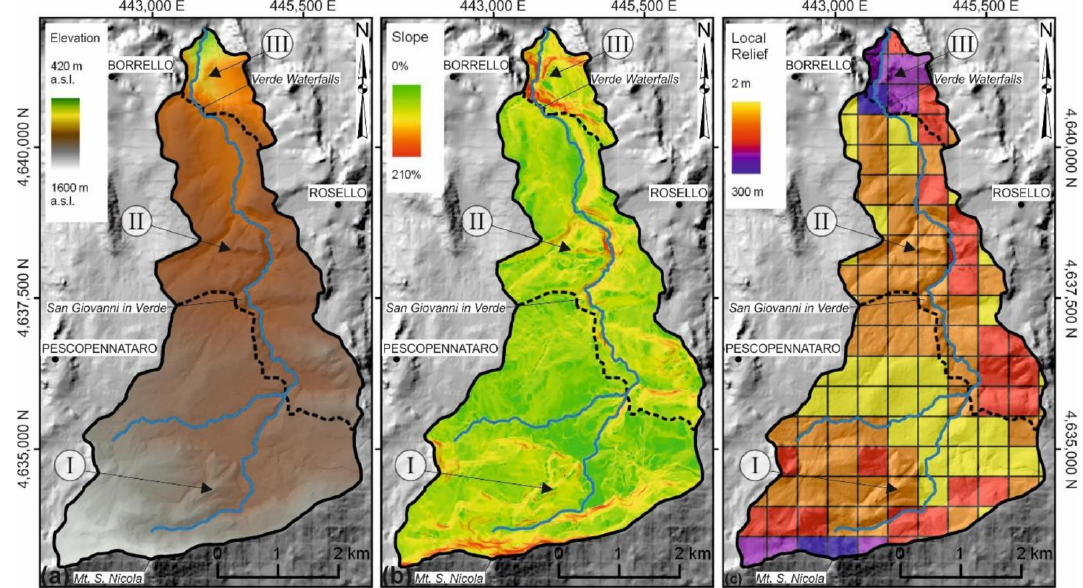
Figure 6. Physiographic features of the study area: ( a ) elevation map; ( b ) slope map; ( c ) local relief map. The dashed black line indicates the orographic sector boundary (numbers I, II, III); the blue line, the main course of the Verde Stream; the black line, the watershed